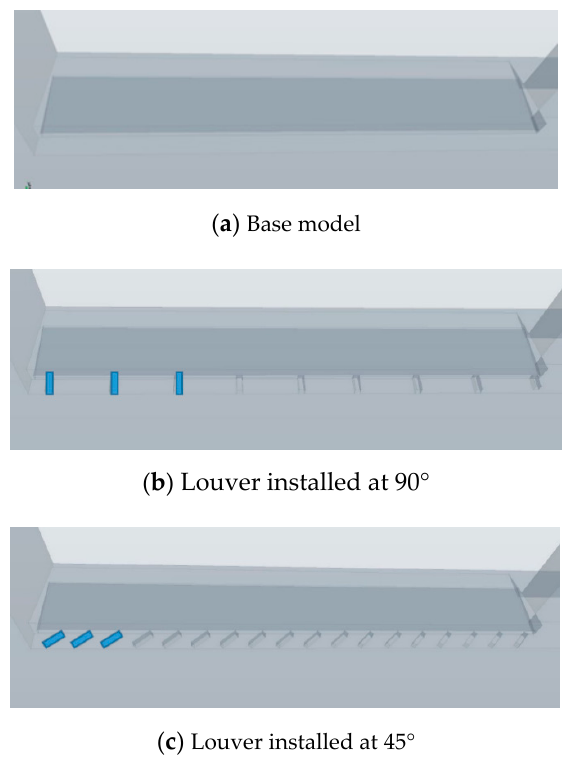
Figure 7. Modeling of the installation angle setting applied to simulation.